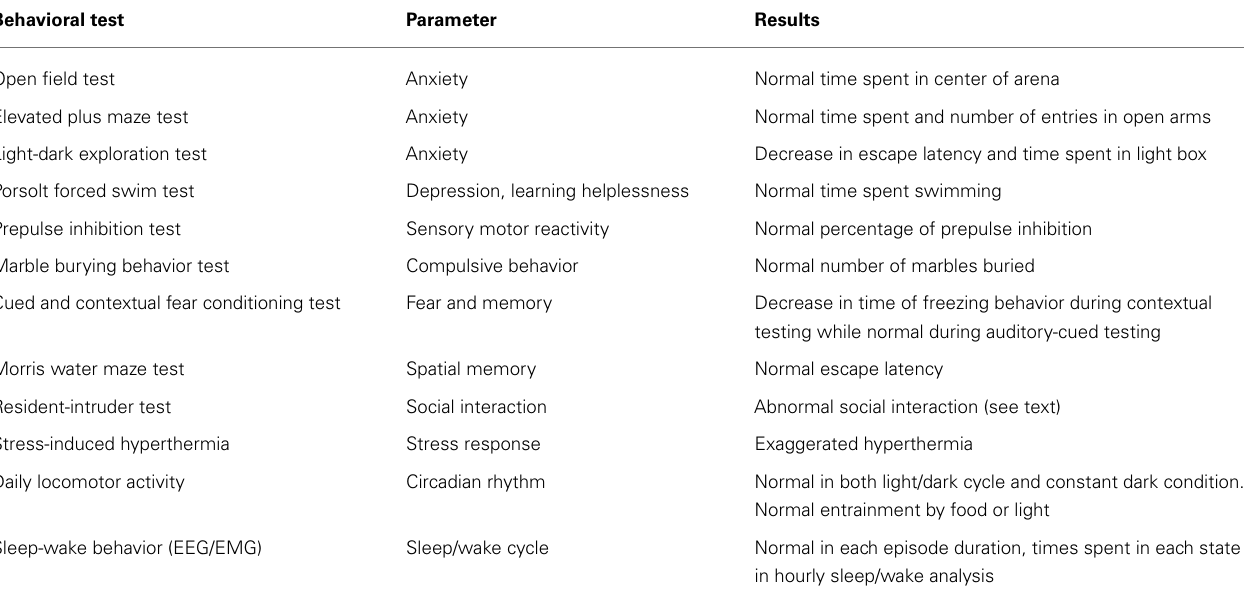
Table 2 | Summary of behavioral phenotypes of NPBWR1 knockout mice (modified from Nagata-Kuroiwa et al.,